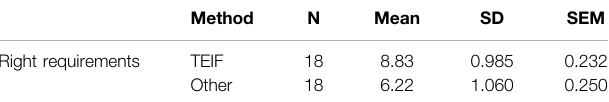
TABLE 10 | Basic statistic of the two groups in evaluating the right